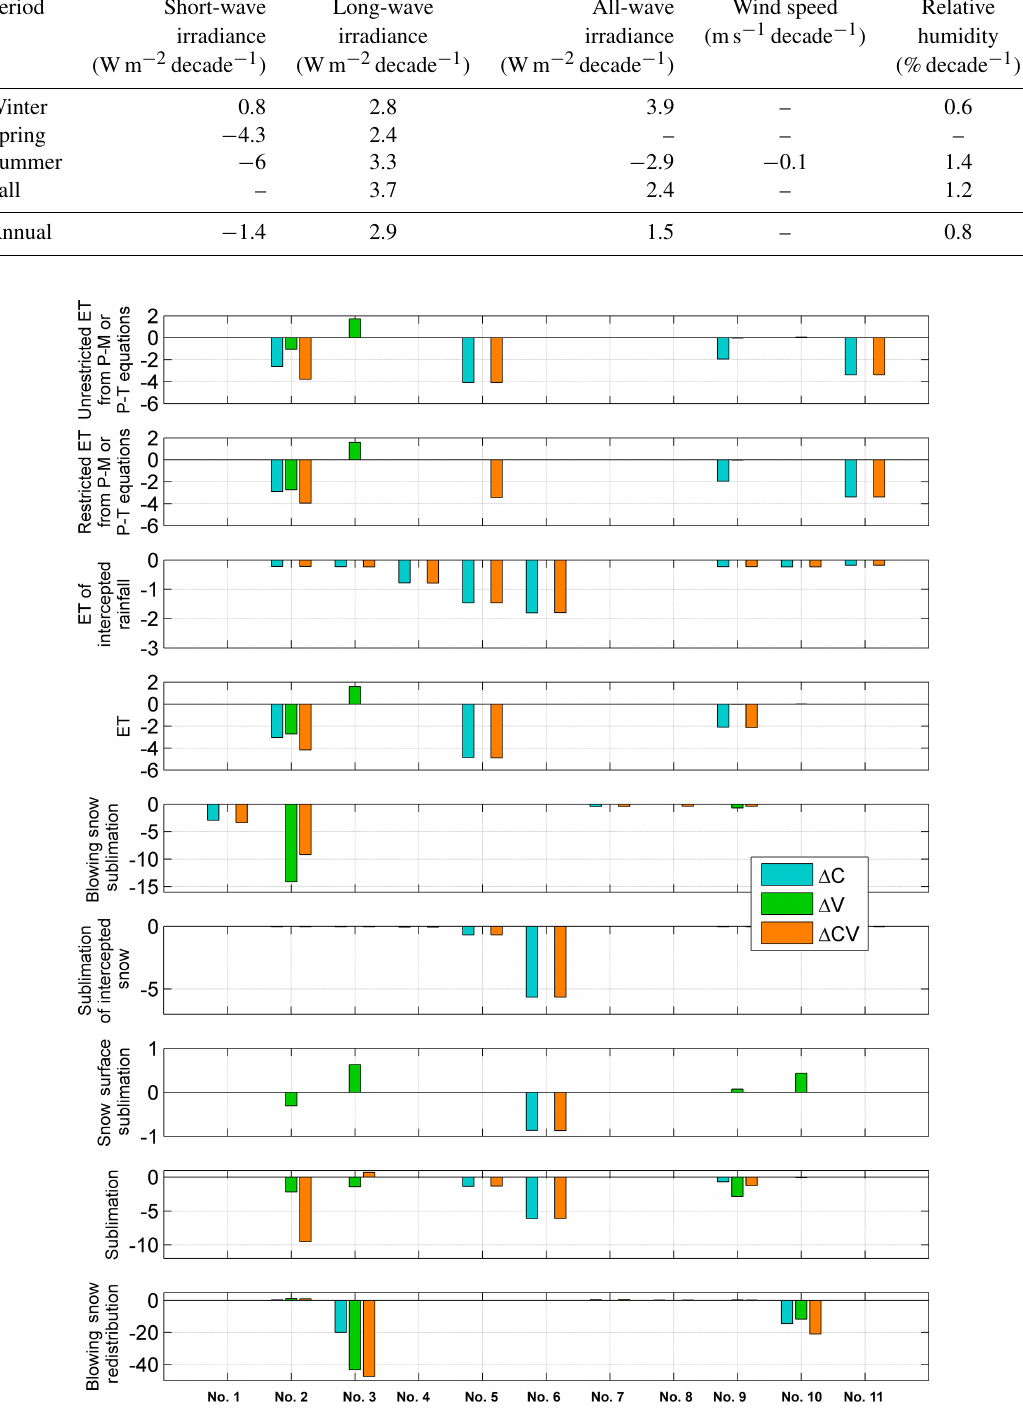
Figure 6. Units in mmdecade − 1 . Scenario comparison of significant trends ( p ≤ 0 . 05) for selected mass fluxes at an HRU-scale. The x axis is as follows: upper tundra (no. 1), upper sparse shrubs (no. 2), upper gully/drift (no. 3), close shrubs (no. 4), taiga forest (no. 5), forest (no. 6), lower tundra (no. 7), open water (no. 8), lower sparse shrubs (no. 9), lower gully/drift (no. 10) and wetland (no.